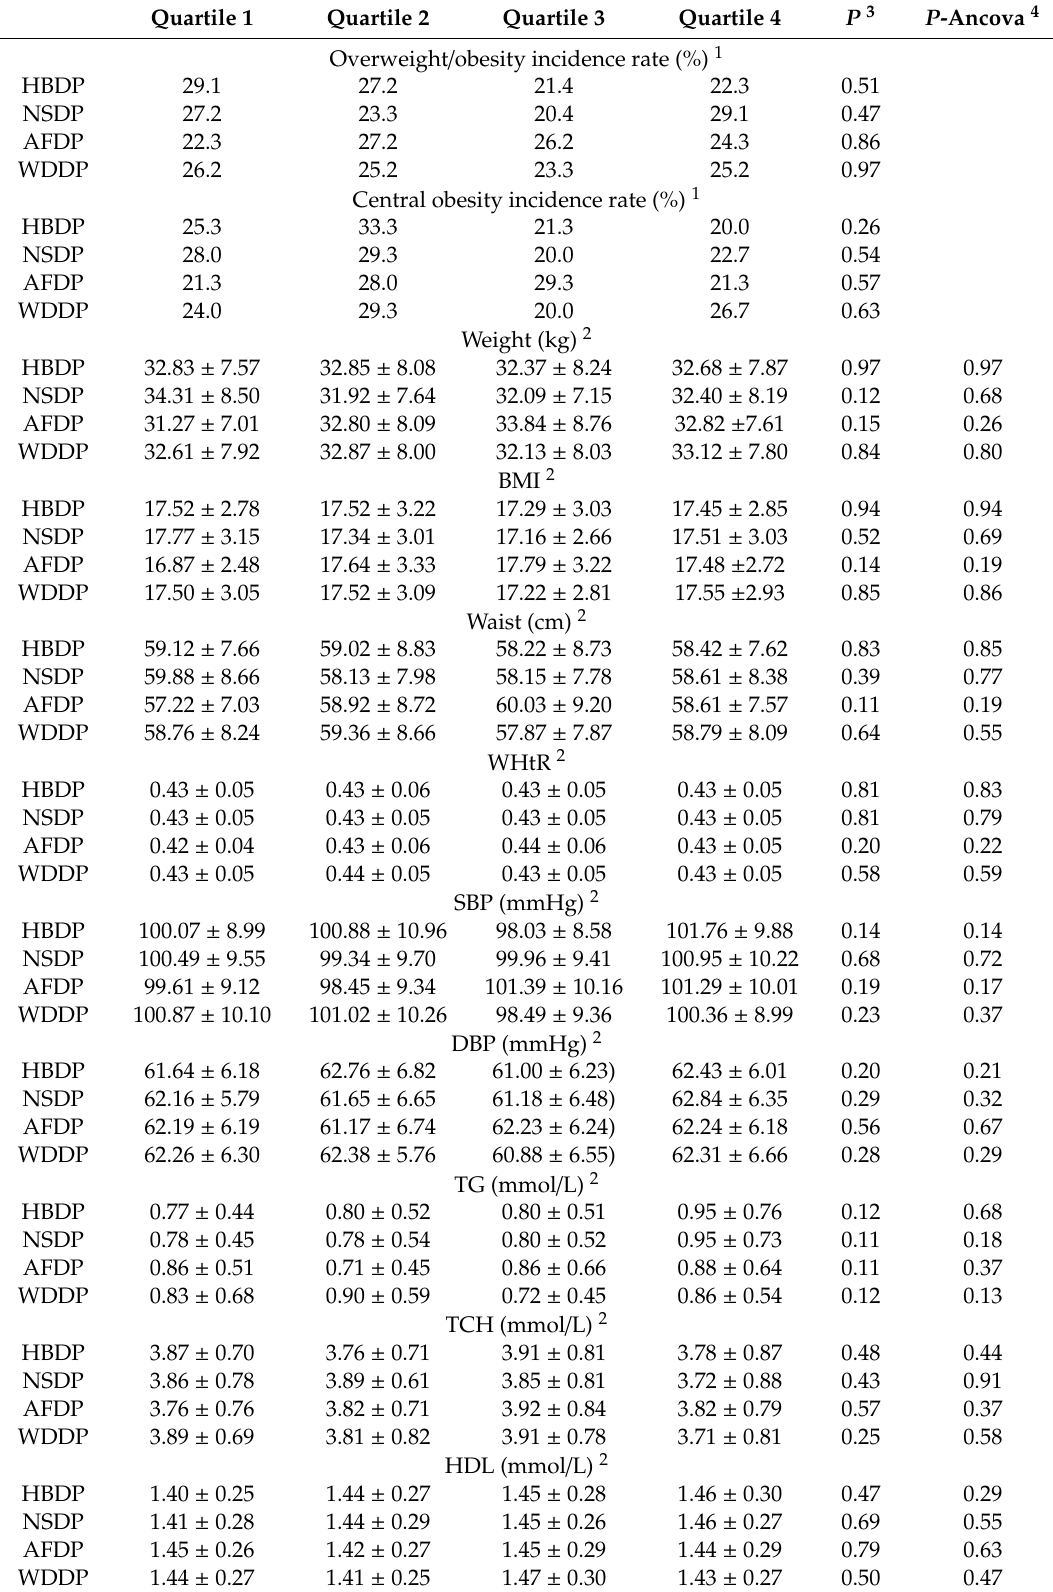
Table 5. Obesity-related indices of male children by quartile of dietary